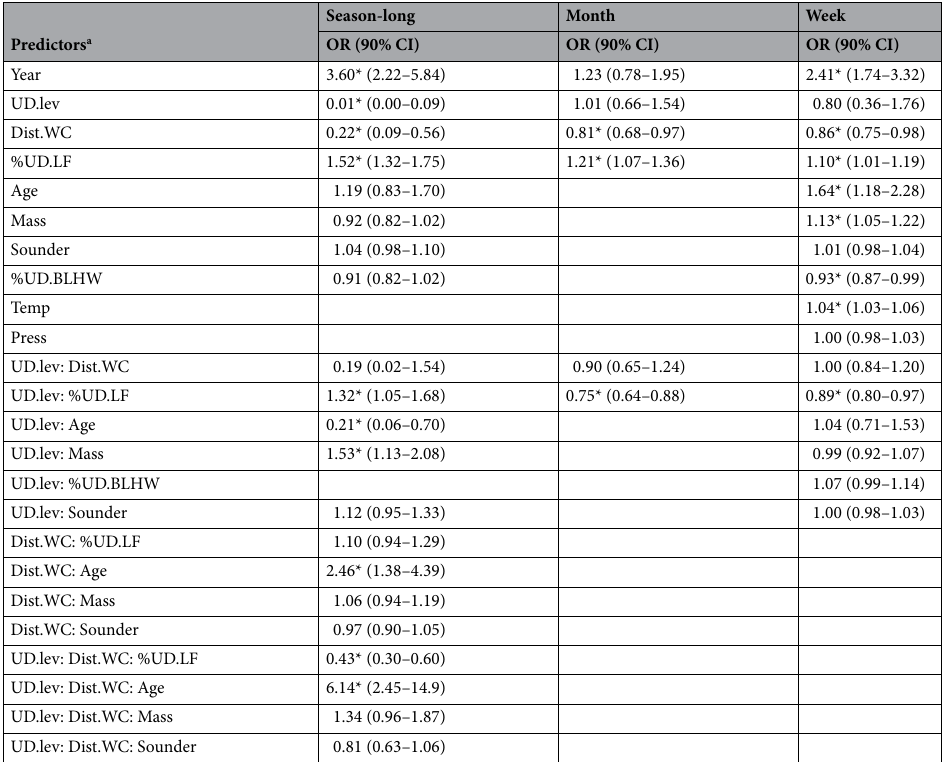
Table 2. Odds ratios (OR) and 90% confidence intervals (CI) for the top supported model of two-dimensional utilization distribution (UD) overlap, estimated as the proportional area of UD overlap, for wild pigs ( Sus scrofa ) across time periods (Season-long [ n season = 2; n pigs = 14], Month [ n months = 6; n pigs = 18], and Week [ n weeks = 26; n pigs = 17]) tracked on Savannah River Site, South Carolina, USA during 2014 and 2016. Colons separating covariate names denote interaction terms and asterisks denote 90% CI of odds ratios that did not overlap 1. a UD.lev = utilization distribution (UD) contour level (i.e., 95% and 50% contours representing home ranges and core areas, respectively); Sounder = Sounder size; Mass = body mass (kg); Temp = temperature (C°); Press = barometric pressure (mb); HA.UD.LF = hectare (ha) of UDs within the landfill boundary; %UD. LF = percent of UDs within the landfill; HA.UD.BLHW = ha of UDs within bottomland hardwood/wetland cover; %UD.BLHW = percent of UDs within bottomland hardwoods/wetland cover; and Dist.WC = distance from UD boundaries to the waste cells within the landfill